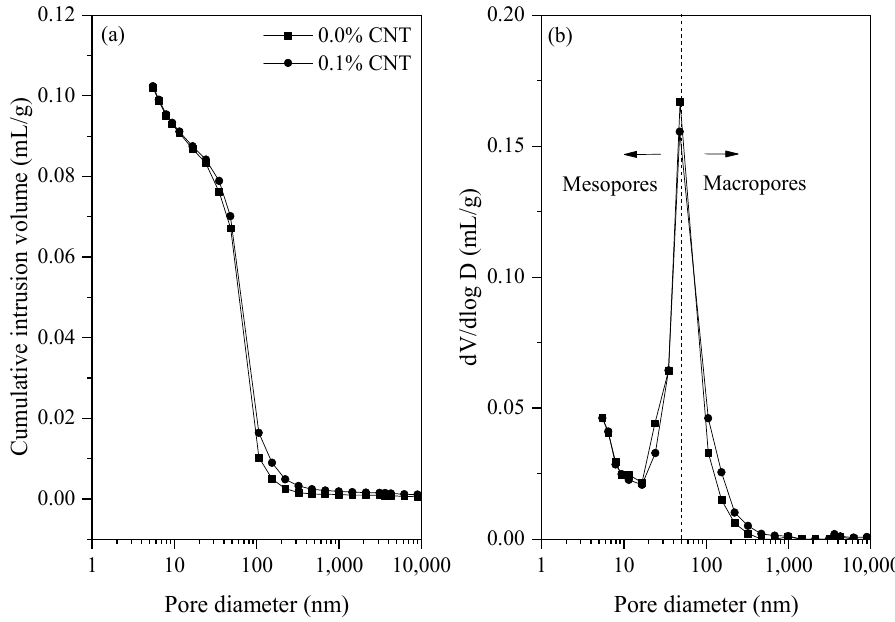
Figure 5. Cumulative pore volume ( a ) and pore size distribution ( b ) of cement pastes after 28 days. Table 2. Cumulative intrusion volume, average pore diameter, and porosity of cement pastes after 28 days.